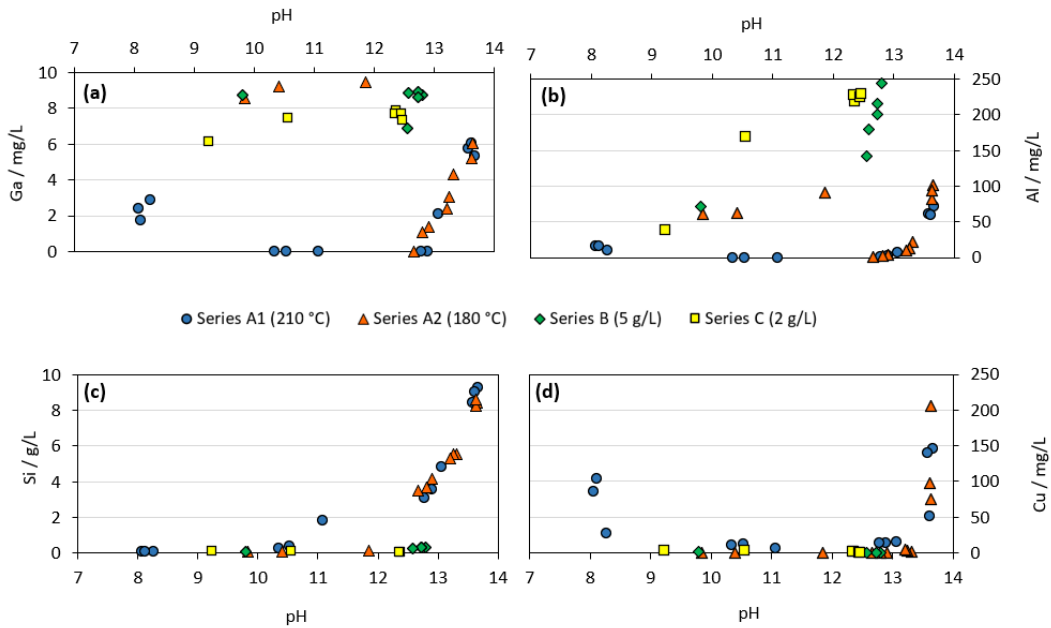
Figure 15. Elemental concentrations of gallium ( a ), aluminum ( b ), silicon ( c ), and copper ( d ) at a final pH after leaching for all test runs (series A1, A2, B, and C).